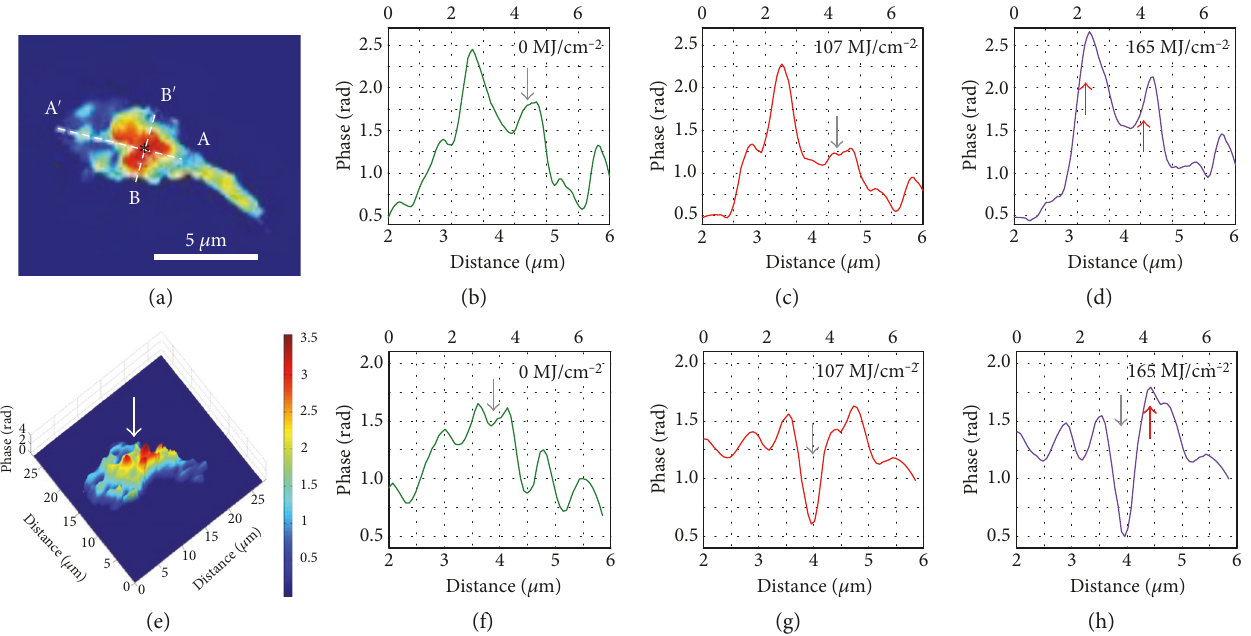
Figure 8: (a) Phase map of the sperm cell region reconstructed at the focus plane; the phase pro fi le along the lines BB ′ (b – d) and AA ′ (f – h) and the Raman spectra in the point ( ∗ ) are monitored during the laser exposition. (e) 3D representation of the phase map of the investigated spermatozoon obtained by digital holography microscopy